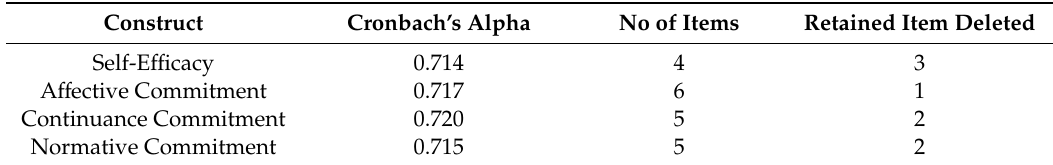
Table 1. Reliability tests for the